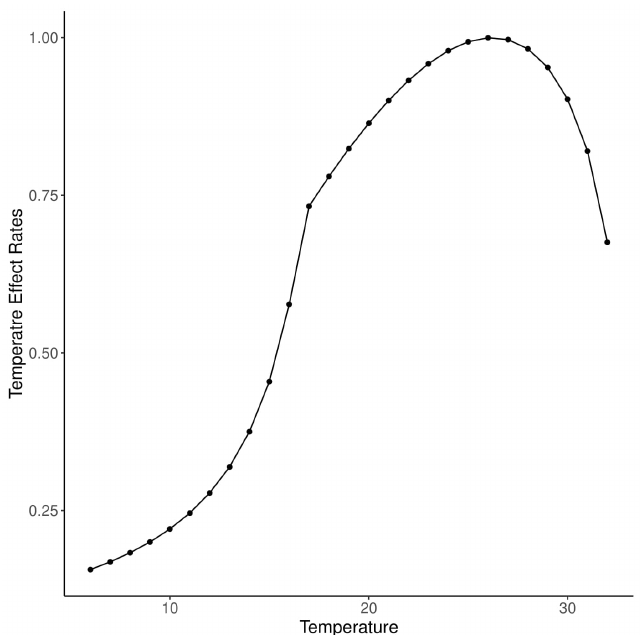
Figure 4. Temperature effect rate plot of the developing rate of PM in response to daily temperatures from 6 ◦ C to 32 ◦